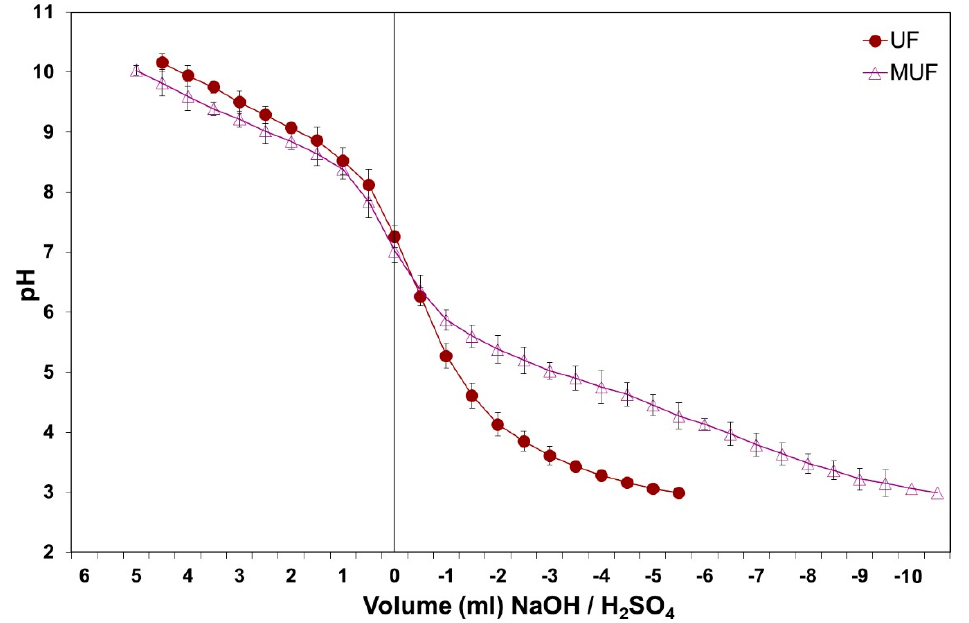
Figure 3. Adhesive type influence on the oak/pine mixture pH and buffer capacity, with 10% oak chips, after defibering and gluing.